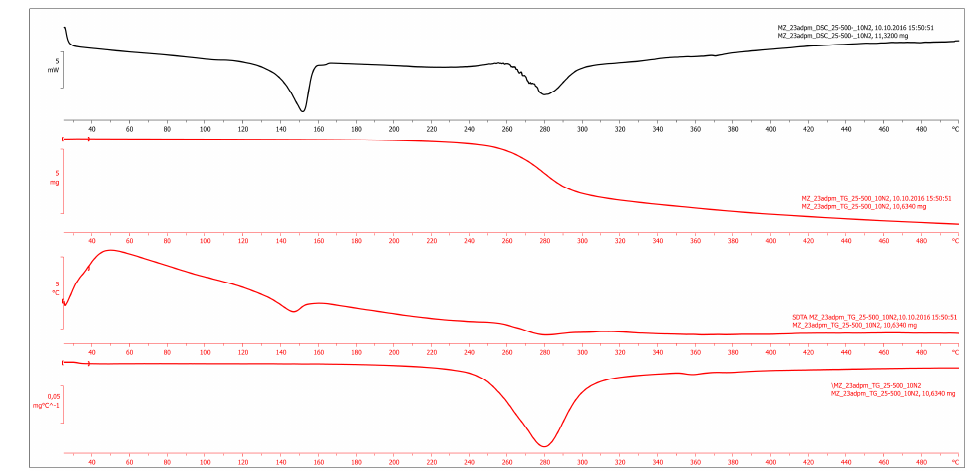
Figure C2. DSC, TG, SDTA and DTG curves of oOHsaladpm .